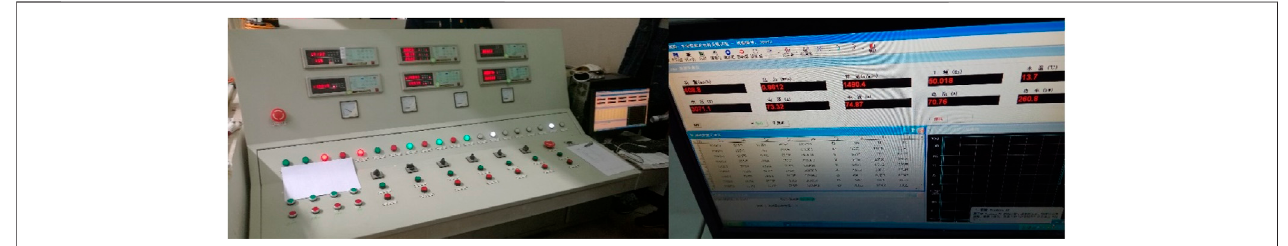
FIGURE 13 | Measurement and control